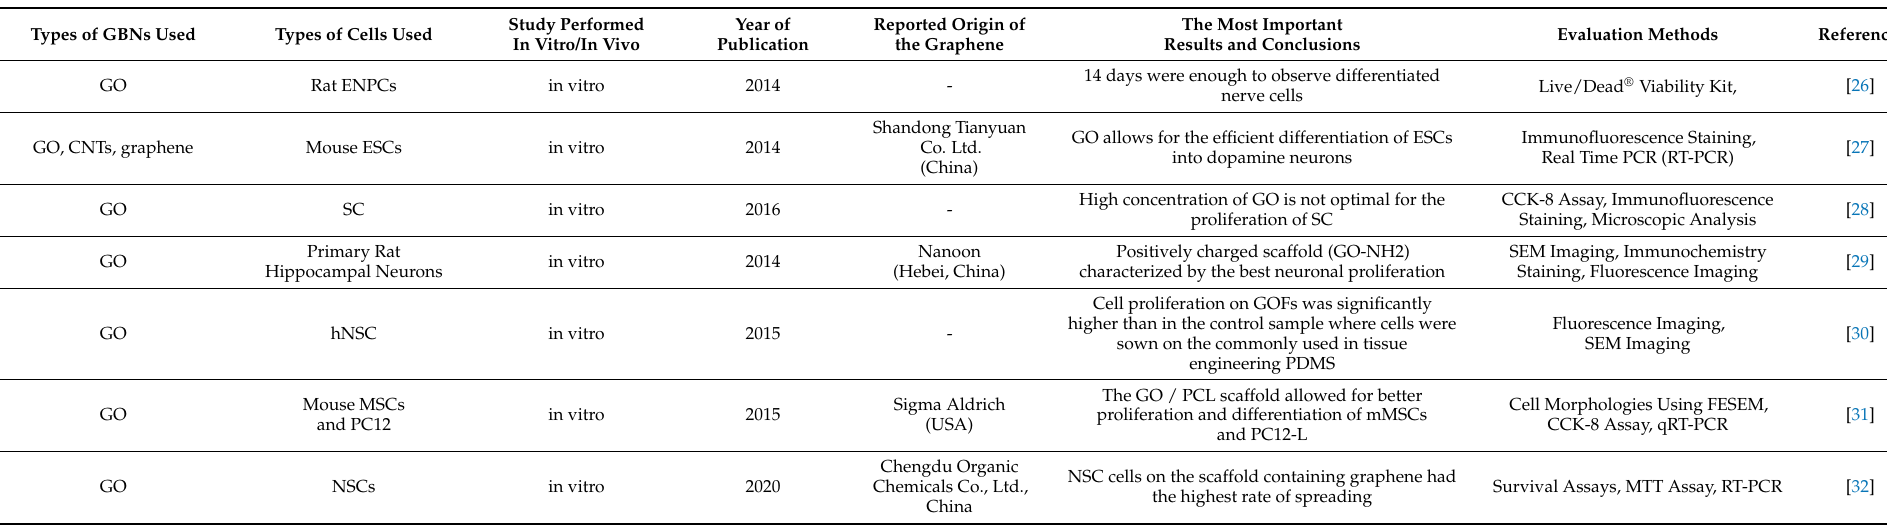
Table 1. List of relevant studies utilizing GO and rGO.